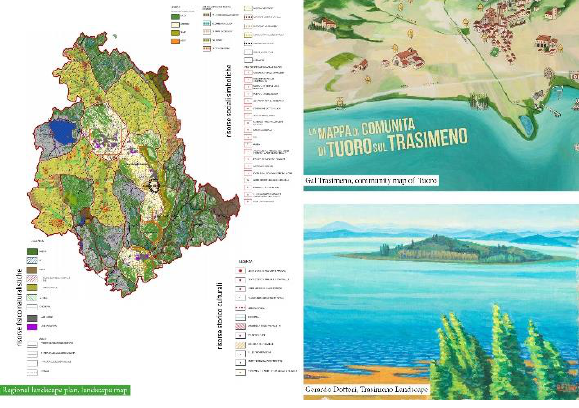
Figure 1 . Different types of